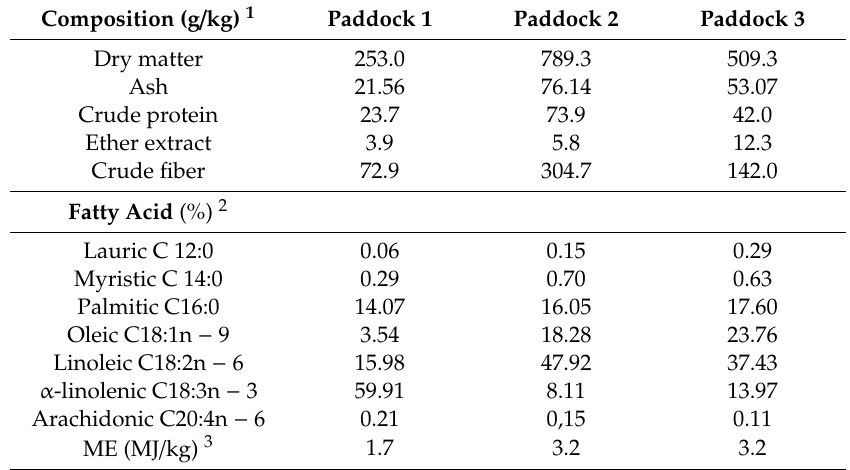
Table 1. Nutritional composition of the available pasture for the outdoor